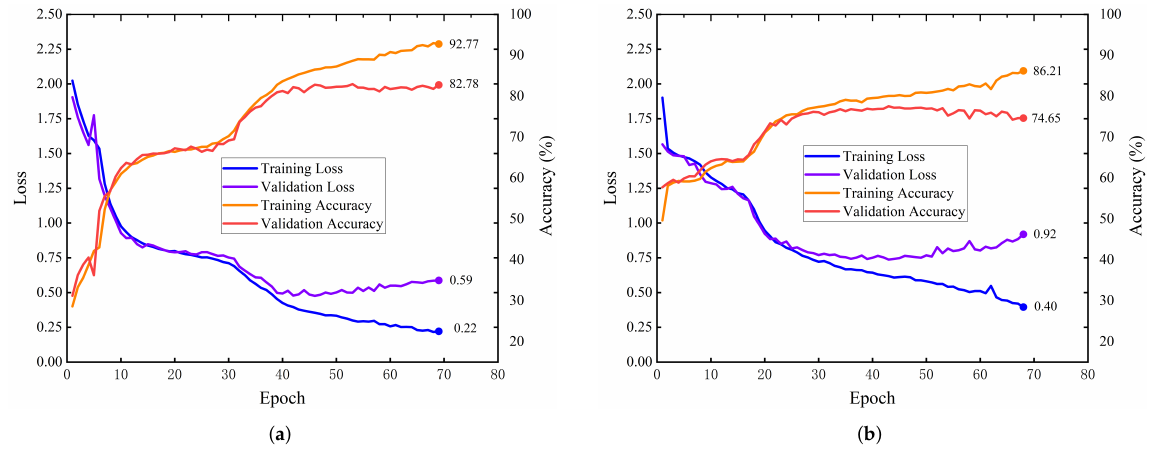
Figure 5. Training curves of LSTM2 on the ( a ) 2016A-1 and ( b ) 2016A-50